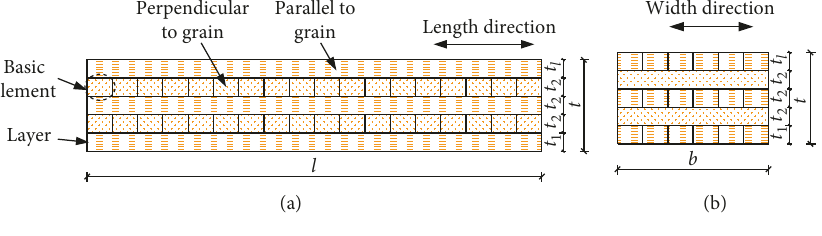
Figure 9: Details of one-way CLB slabs. Table 3: Dimensions of one-way CLB slabs.